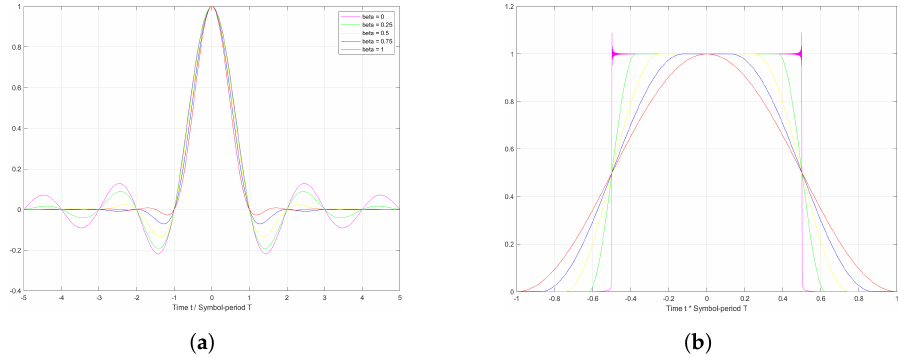
Figure 11. Impulse response and frequency response of raised cosine filter. ( a ) Impulse Response, ( b ) Frequency